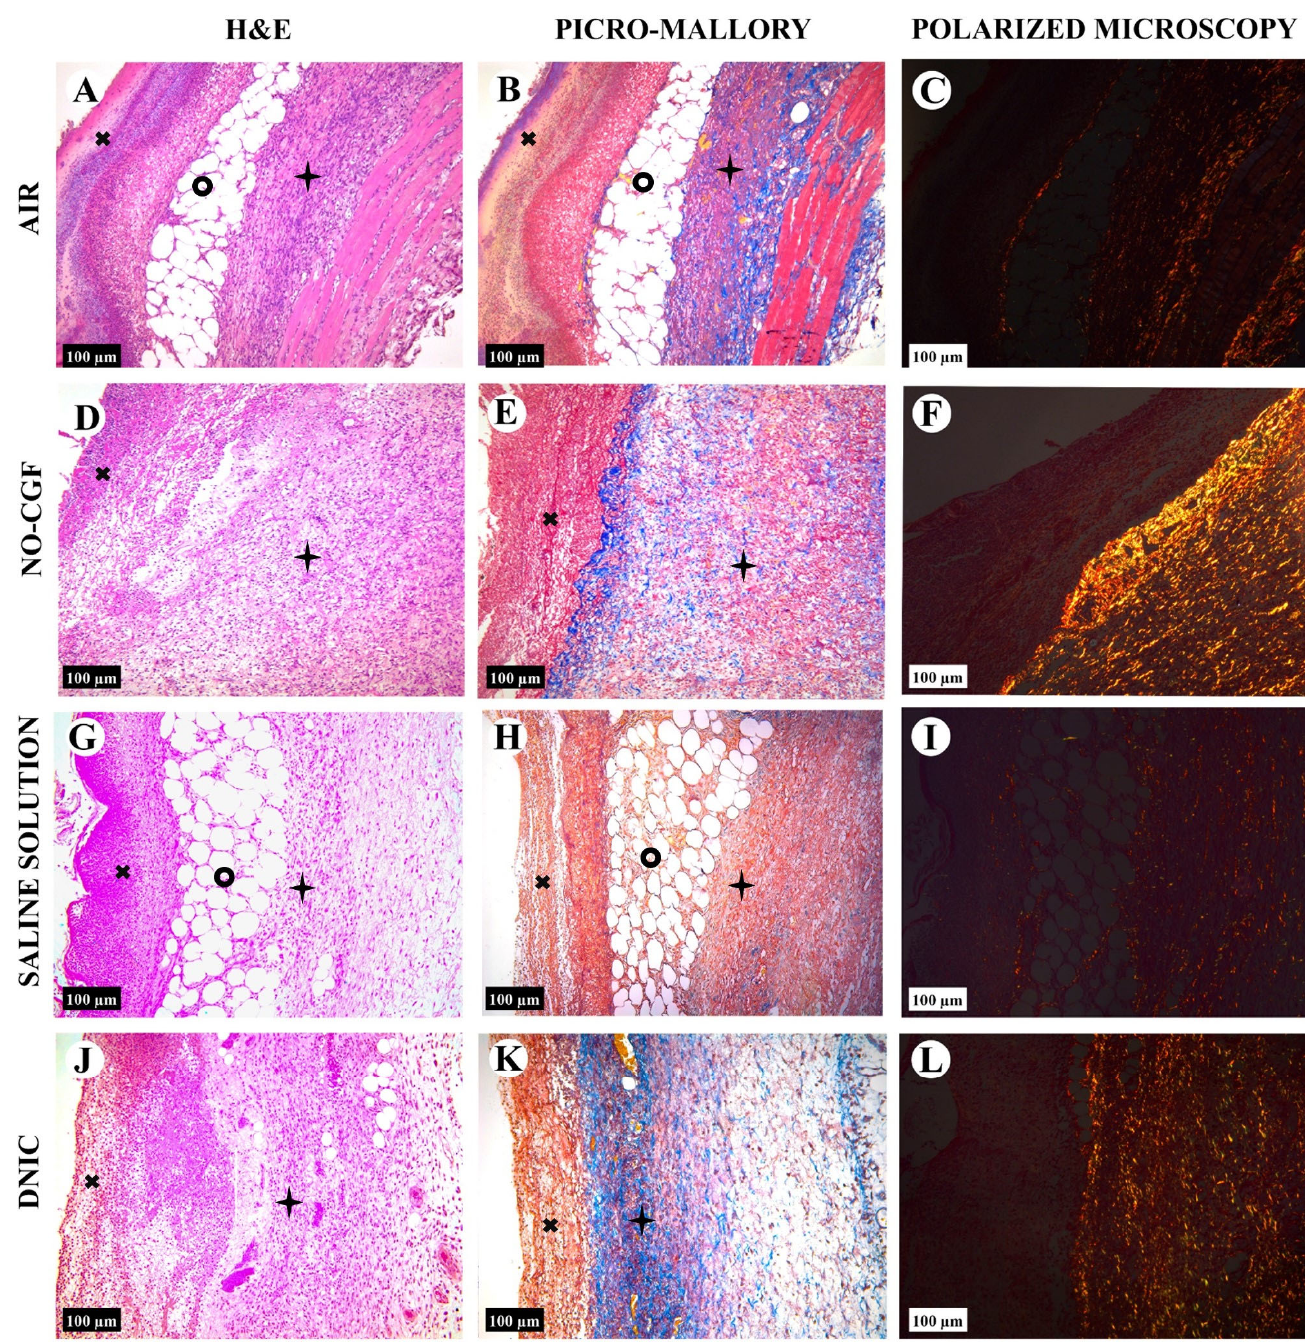
Figure 3. Histology of the wounds at post-operative day 4, hematoxylin and eosin staining ( A , D , G , J ), picro-Mallory staining ( B , E , H , K ) staining and polarized light microscopy; picrosirius red staining ( C , F , I , L ), scale bar—100 μ m. —fibrin clot, —granulation tissue, —adipose tissue.